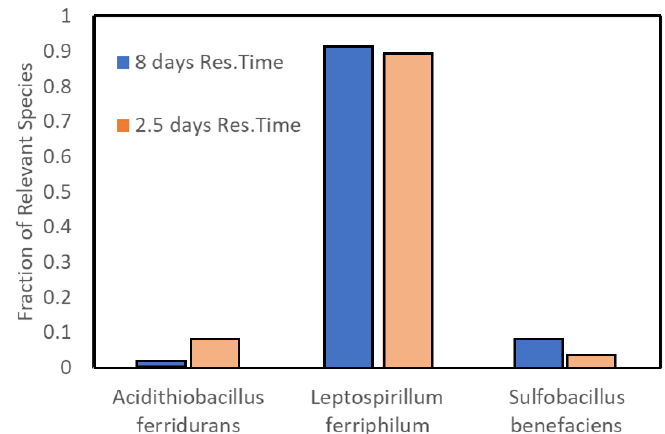
Figure 9. Genome sequencing data from samples originating from bioreactor solutions from 2.5- and 8-days residence time tests at 500 RPM, 1 l/min air flow, 35 °C, and 6 wt % solids conditions showing the relative fraction of species that are generally identified with biooxidation of pyrite.